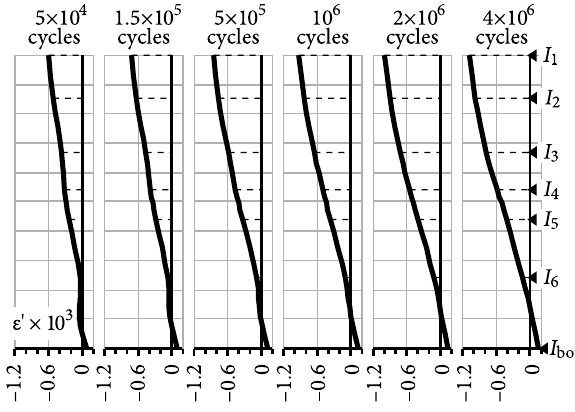
Fig. 8. The distribution of relative strains across the section of experimental PC beam at max loading level corresponding to 60% of the ultimate Fig. 8 validates the hypothesis of linear strain distribution